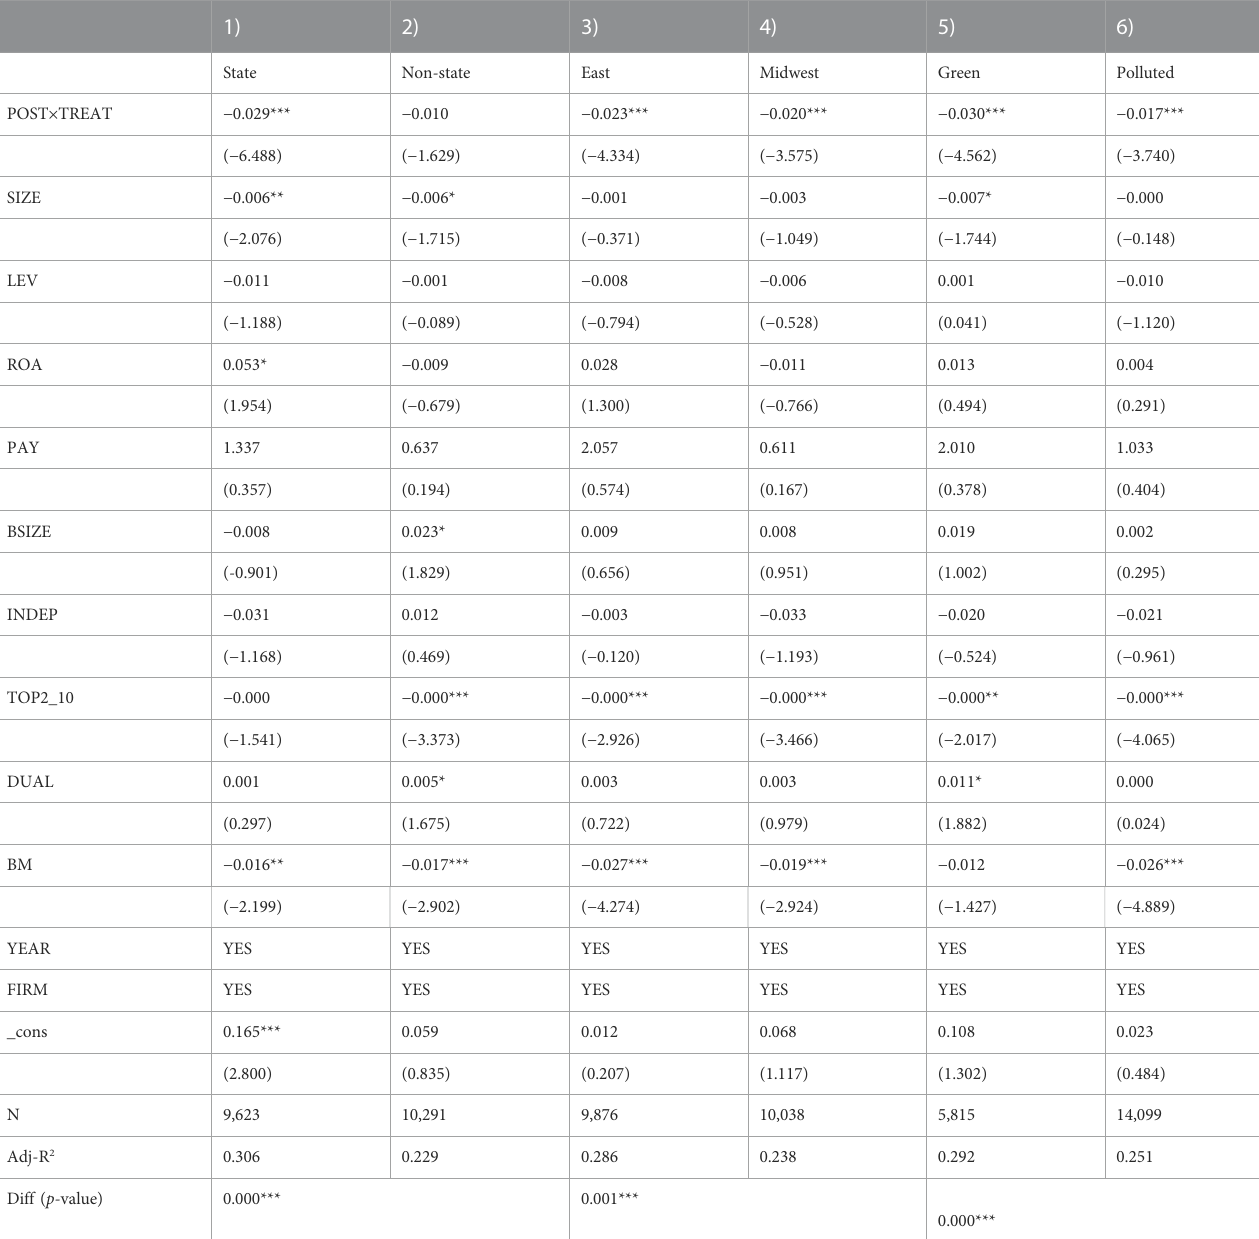
TABLE 9 Heterogeneity: nature of